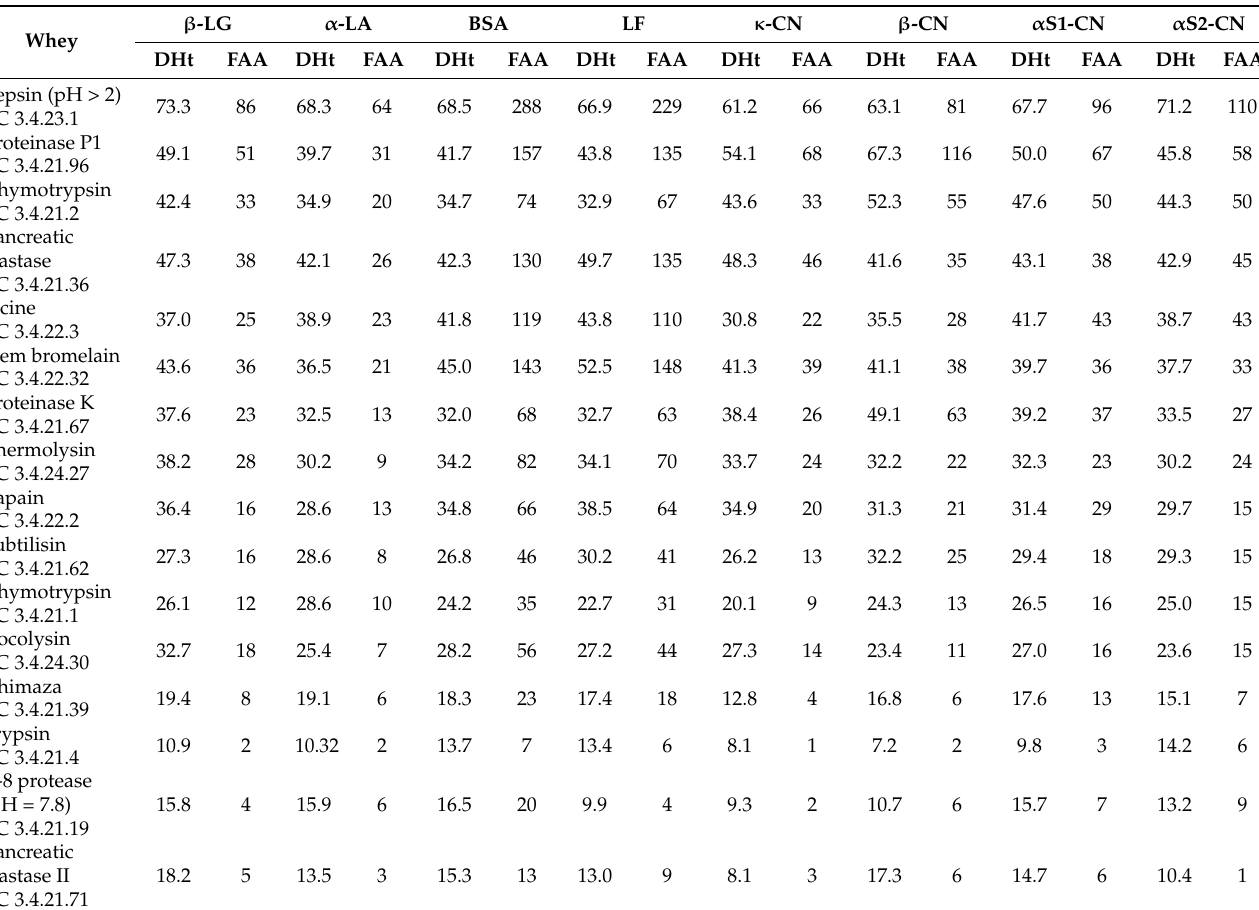
Table 2. Evaluation of the predicted degree of hydrolysis of milk whey proteins and the release of free amino acids during the hydrolysis modeling by different